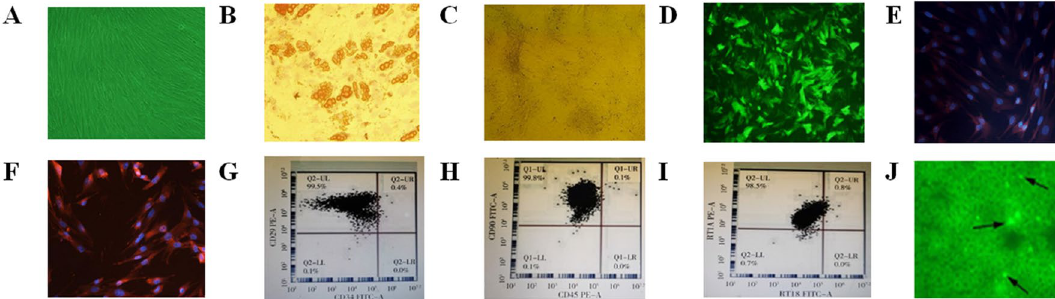
Figure 1. Morphology, characteristics, phenotype and HO-1 transfection of BMMSCs. ( A ) The morphology of BMMSCs in the third generation (×100). ( B ) Adipogenic analysis of BMMSCs. ( C ) Osteogenic